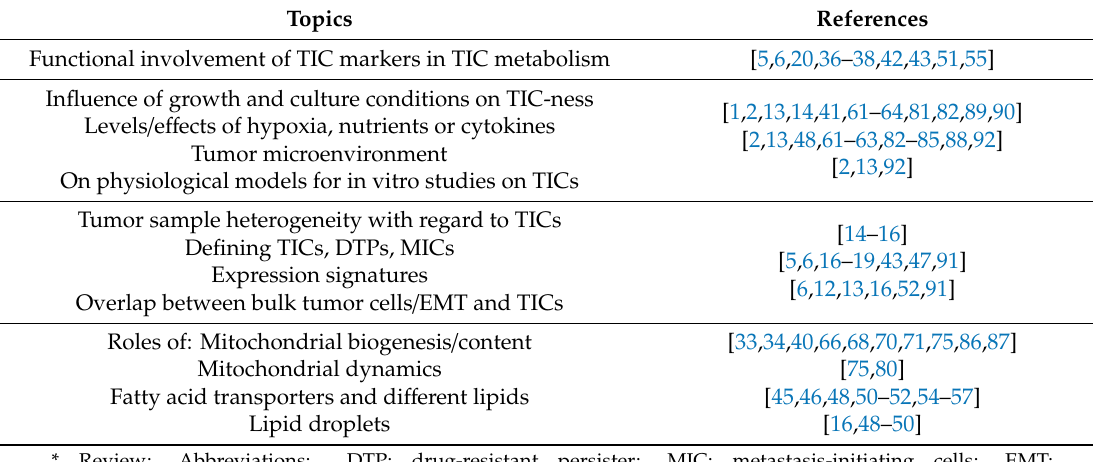
Table 2. Some key topics in further research on TICs. Numbers refer to cited references that either directly address, or may be associated with, each topic. Some references can thus be found in several of the